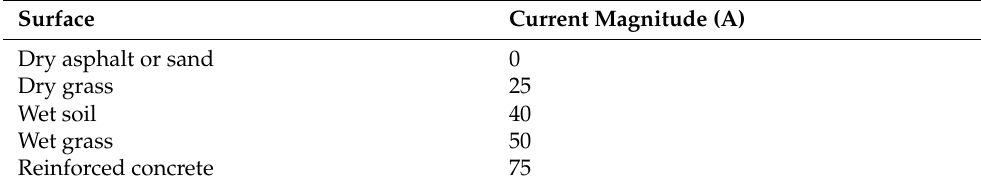
Table 1. Fault magnitude on different surfaces